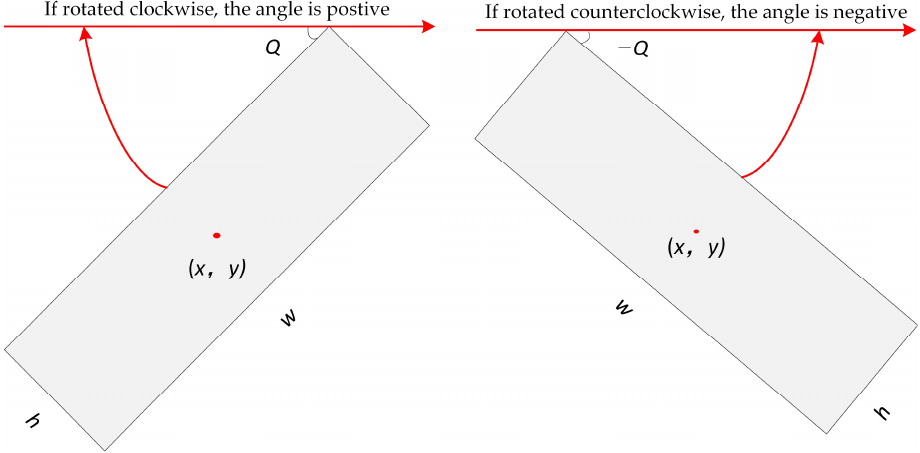
Figure 2. Schematic diagram of the oriented bounding box.